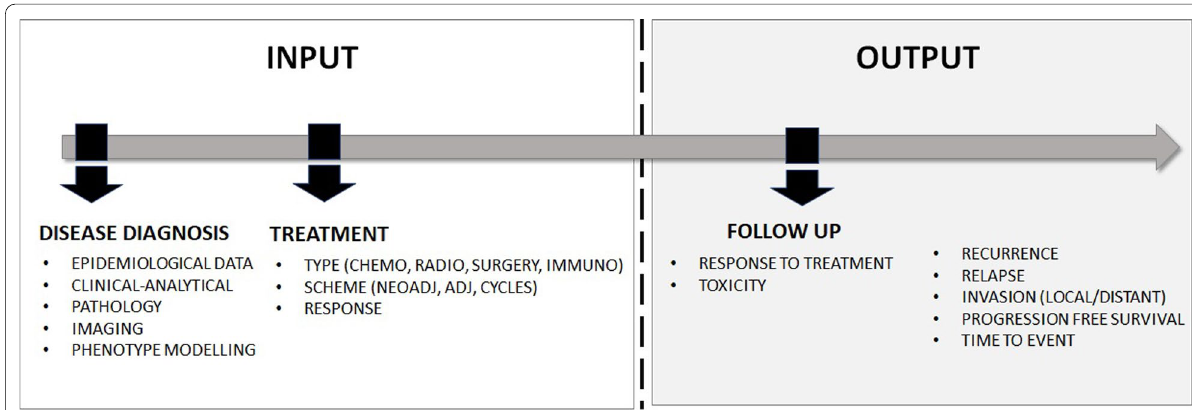
Fig. 2 Clinical endpoints (CEPs) and type of data obtained in observational oncology studies